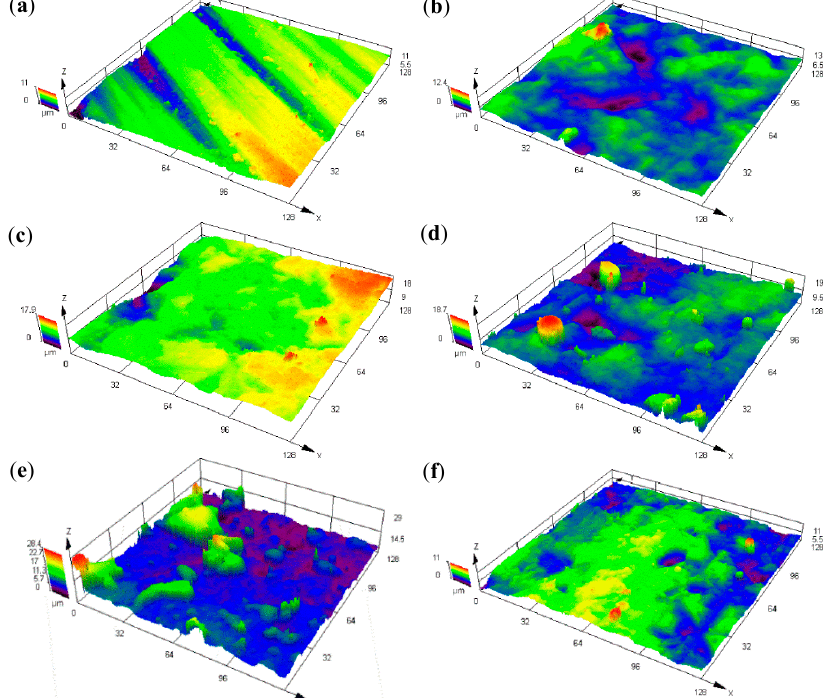
Figure 7. Laser confocal microscopy images demonstrating the topography of the treated core material